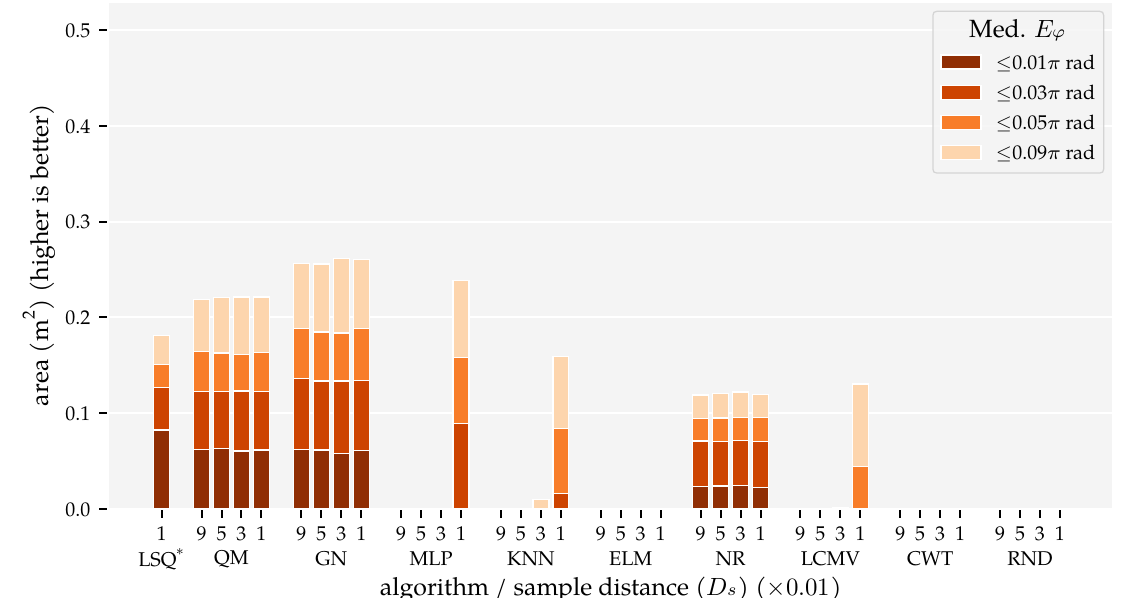
algorithm / sample distance ( 𝐷 𝑠 ) ( ×0.01 ) Figure 6. Total areas with a median movement direction error E ϕ (Equation (5)) below 0.01 π rad, 0.03 π rad, 0.05 π rad for the training and optimisation sets with a varying minimum distance between source states D s (see Section 2.3 and Table 1) and the (x + y) sensor configuration at the σ = 1.0 × 10 − 5 ms − 1 noise level. The median movement direction error was computed for 2 × 2 cm 2 cells. Note, the bar for LSQ* is based on the (x + y) condition in Analysis Method 2.